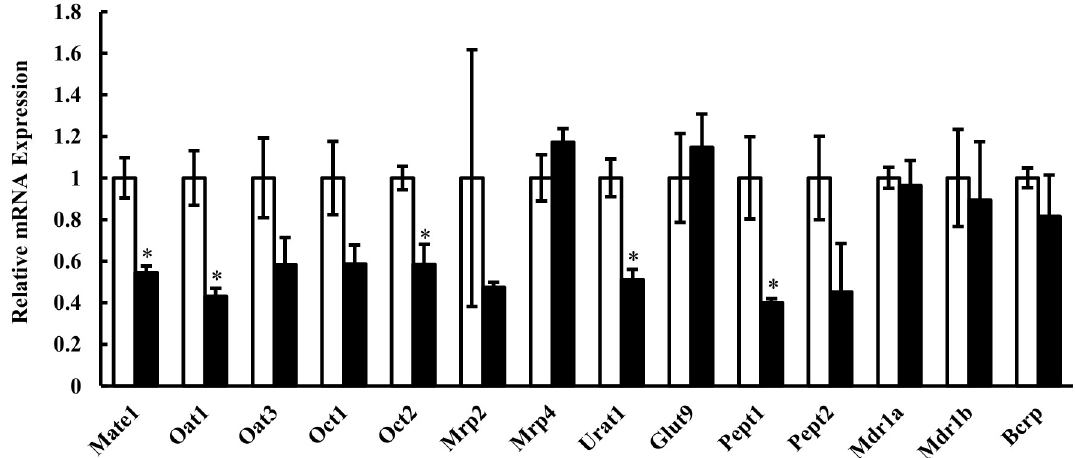
Fig 2. Relative mRNA expression levels of transporters in kidney of control and hyperuricemic rats. Relative mRNA levels normalized to Gapdh mRNA in hyperuricemic rats (closed columns) are shown as the ratio to those in control rats (open columns). Data are presented as mean ± SEM (n = 3–7). � p < 0.05 vs. control rats.